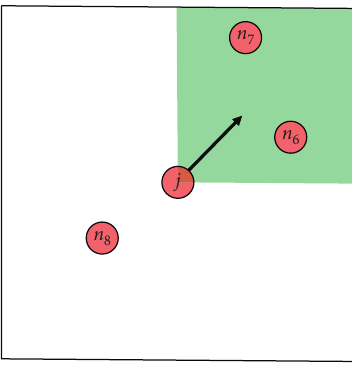
Figure 8: Emotional perception domain of individual j